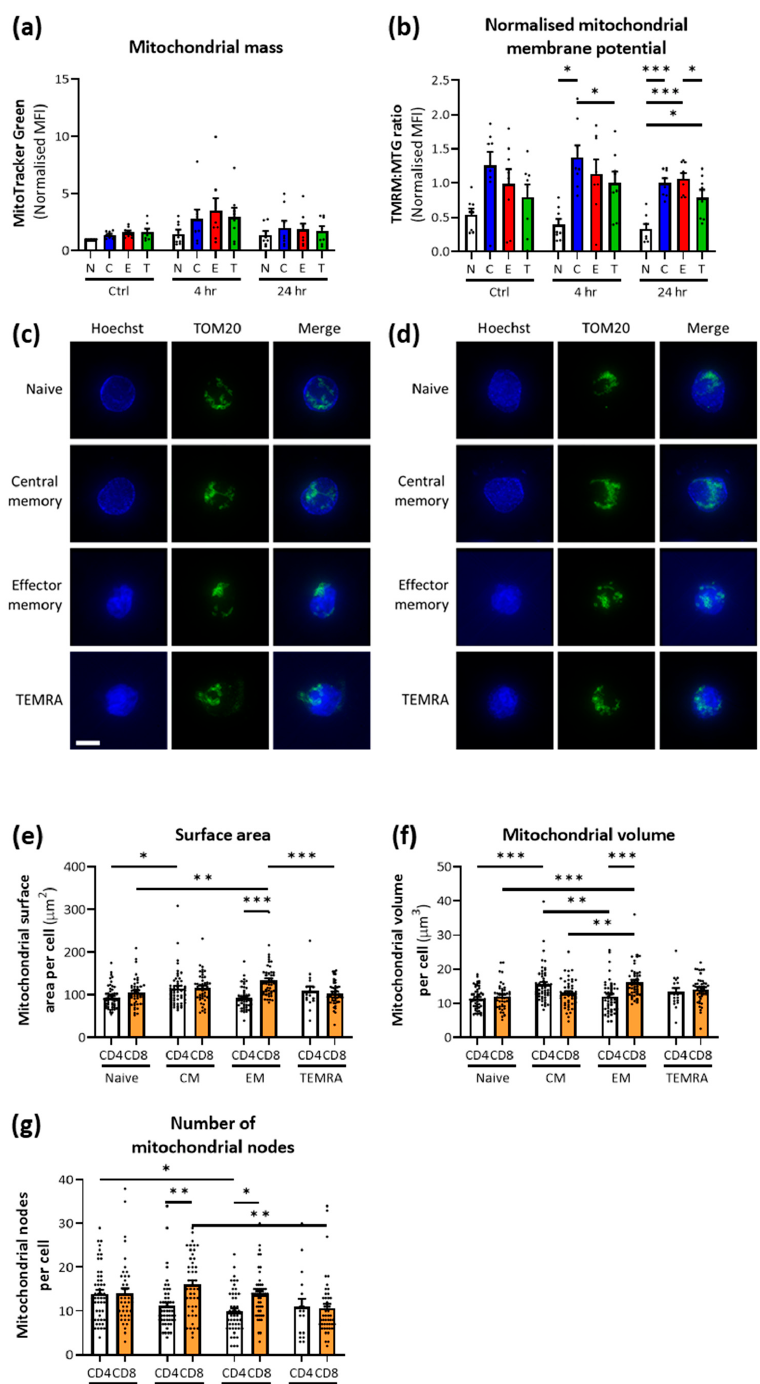
Figure 3. Analysis of mitochondrial mass and membrane potential in CD4+ and CD8+ T cells. Flow cytometry analysis of ( a ) comparison of MitoTracker Green staining between CD4+ T cell subsets ( n = 8; expression normalised to unstimulated naïve cells) and ( b ) comparison of mitochondrial membrane potential between CD4+ T cell subsets ( n = 8; TMRM staining normalised to mitochondrial mass). Representative super-resolution microscopy imaging of sorted ( c ) CD4+ T cells and ( d ) CD8+ T cells (scale bar = 10 µ m; middle plane image), and analysis of ( e ) mitochondrial surface area ( n = 40), ( f ) mitochondrial volume ( n = 40) and ( g ) the number of mitochondrial nodes ( n = 40). (Mean + SEM; two-way repeated measures ANOVA with Tukey post hoc analysis; * p < 0.05 ** p < 0.01 *** p <